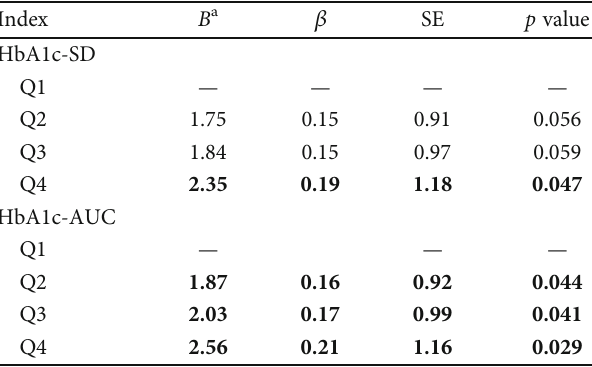
Table 4: Association between degree of oxidized HSA and visit-to- visit variability of HbA1c, as assessed by a multiple linear regression